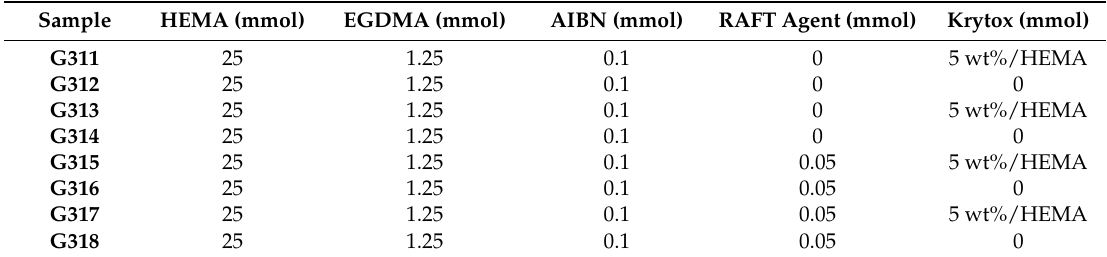
Table 1. Summary of experimental conditions for the FRP or RAFT copolymerization of HEMA/EDGMA in supercritical carbon dioxide (scCO 2 ) ( T = 65 ◦ C, P = 173 bar, t = 24 h, 22% w / v CO 2